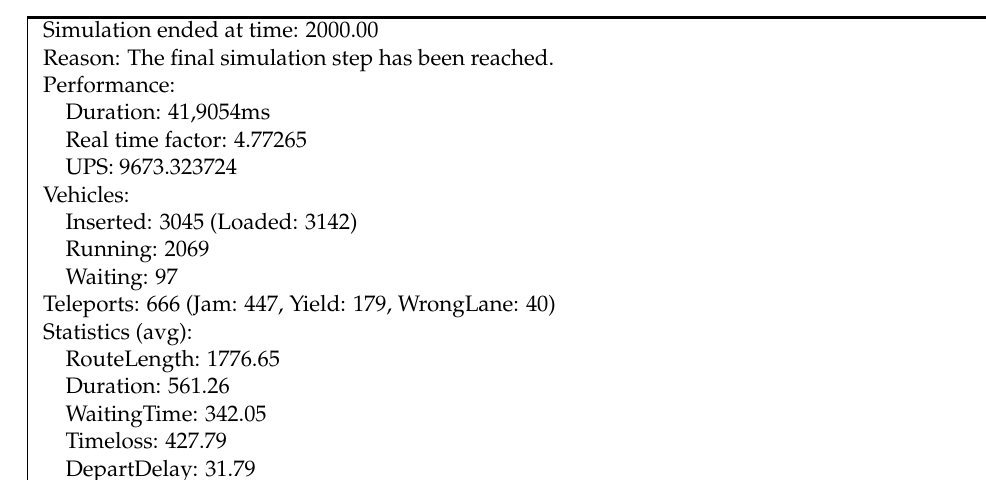
Table 5. Generated simulation report after implementation of improvements 2 and 3.